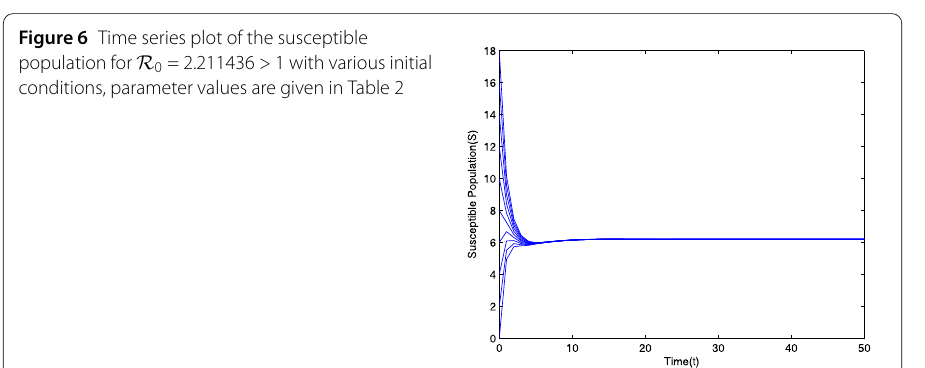
Figure 6 Time series plot of the susceptible population for R 0 = 2.211436 > 1 with various initial conditions, parameter values are given in Table